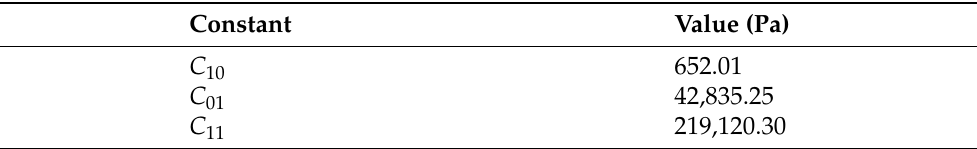
Table 1. Rigidity constants of the isotropic hyperelastic